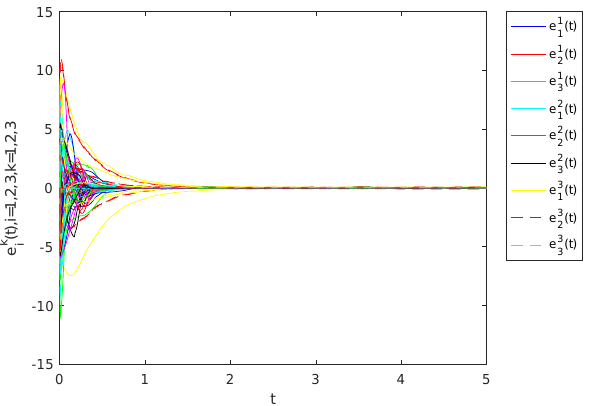
Figure 25. Synchronization error without intra-layer couplings under Controller (17). As pointed out in Remarks 1, 2, and 5, the designed controllers and the synchronization criteria are applicable for the fractional-order multiplex networks without intra-layer coupling and inter- layer coupling. To validate this statement, Figures 12, 13, 24, and 25 are provided. It can be seen that the degraded multiplex networks without inter-layer coupling or intra-layer coupling require less synchronization time compared with the networks containing inter-layer and intra-layer